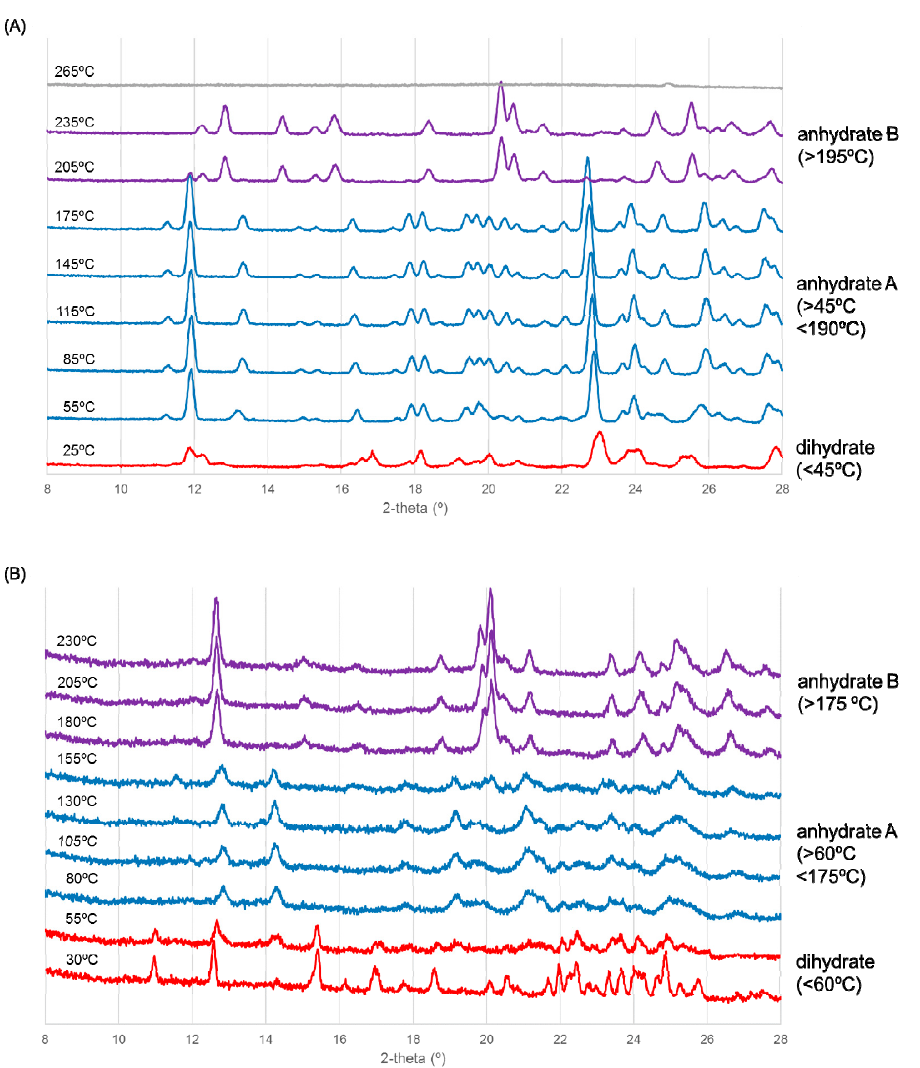
Figure 3. Variable temperature (VT)-X-ray diffraction scanning results for ondansetron ( A ) HBr dihydrate and ( B ) HI dihydrate. Patterns of the dihydrate (red), anhydrate A (blue), anhydrate B (purple) are shown.